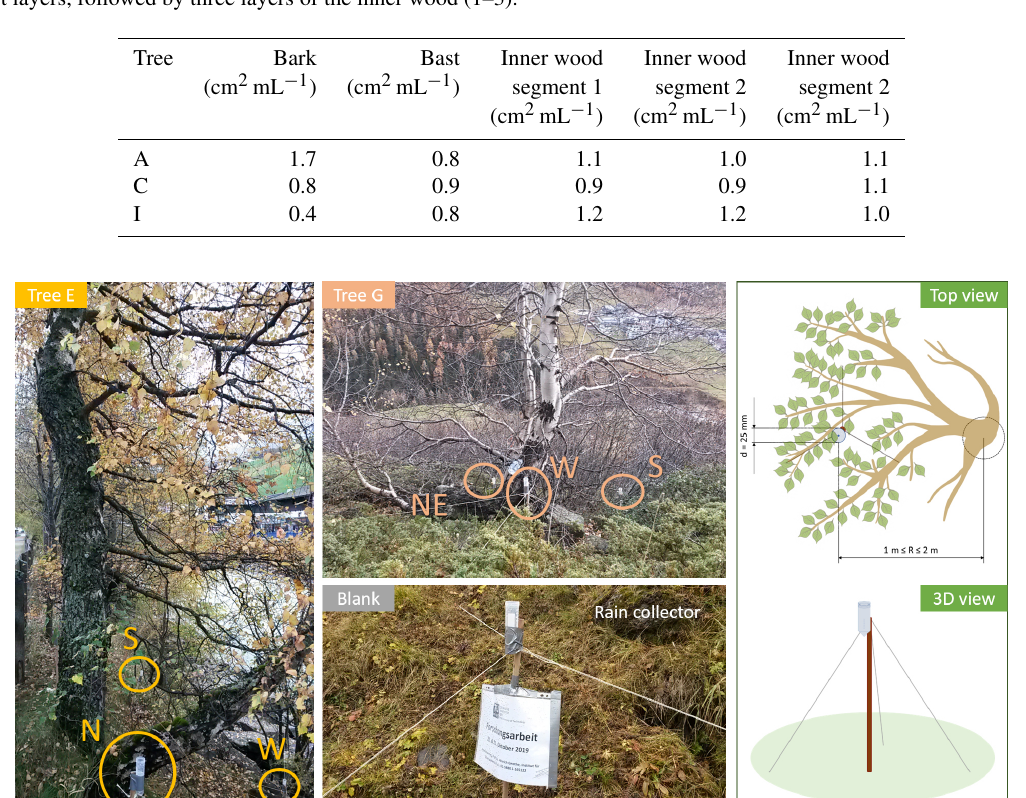
Figure 3. Rain sampling setup underneath Tree E (left, yellow) and Tree G (top middle, light orange). Three to four rainwater collectors were placed underneath each of the sampled trees. Next to the trees of interest, we mounted a control collector (blank, centre middle grey), which was placed in an open terrain. Top view as well as a schematic 3D picture of the rain collector (right, green).